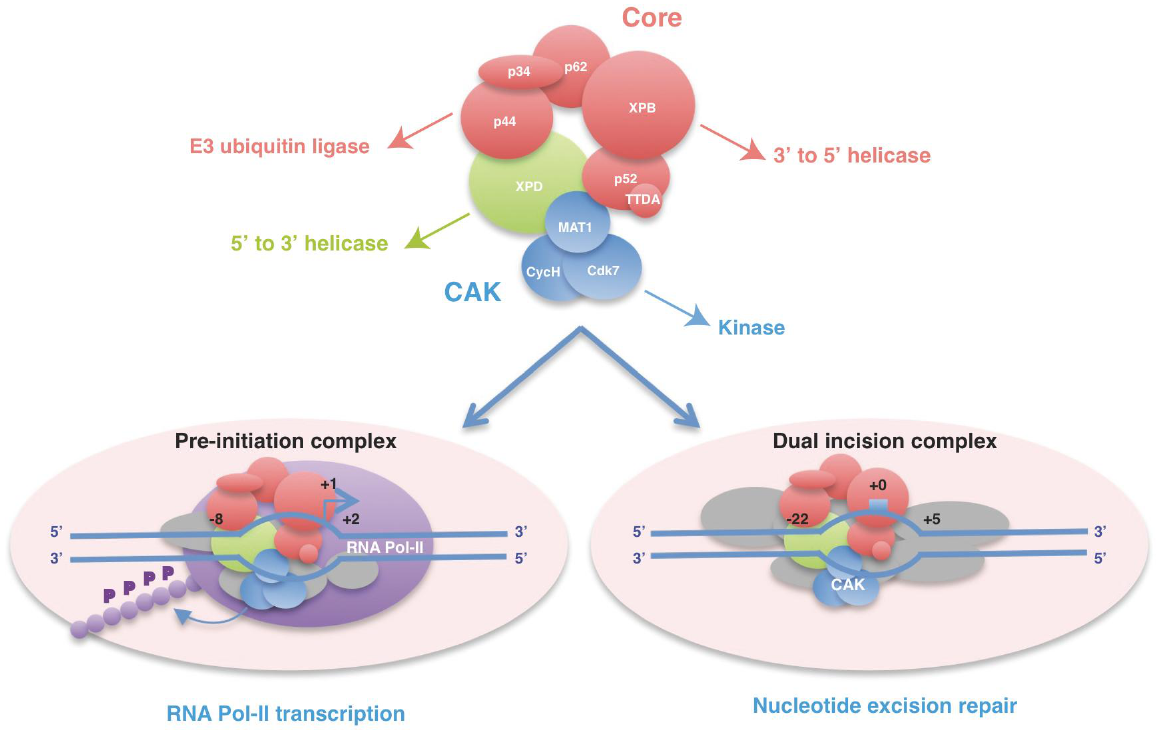
FIGURE 1. A multisubunit and tasks complex. TFIIH is a ten-subunit complex composed of a core (in red; XPB, p62, p52, p44, p34, and TTDA) associated to the CAK (in blue; Cdk7, CycH, and MAT1) through MAT1 and the XPD subunit (in green). Four enzymatic activities are found in TFIIH: XPB and XPD are 3’ to 5’ and 5’ to 3’ helicases, Cdk7 is a kinase, and p44 has been described as an E3 ubiquitin ligase in yeast. The complex is involved both in RNPI- and II-dependant transcription and in nucleotide excision repair. The role of TFIIH in RNPI transcription in unknown. In RNPII-dependant transcription, TFIIH opens DNA around the promoter in the preinitiation complex (–8 to +2 relatively to the transcription start site +1) and phosphorylates the carboxyl terminal domain of the RNPII (purple) to license transcription. In NER, TFIIH opens DNA around the lesion (–22 to +5 relatively to the lesion in blue square) and assists ERCC1-XPF for the 5’